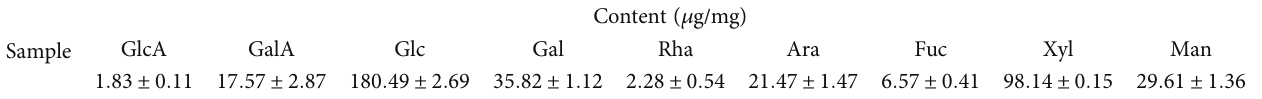
Table 3: Monosaccharide composition of deproteinized ethanol-treated sun fl ower meal. Sample